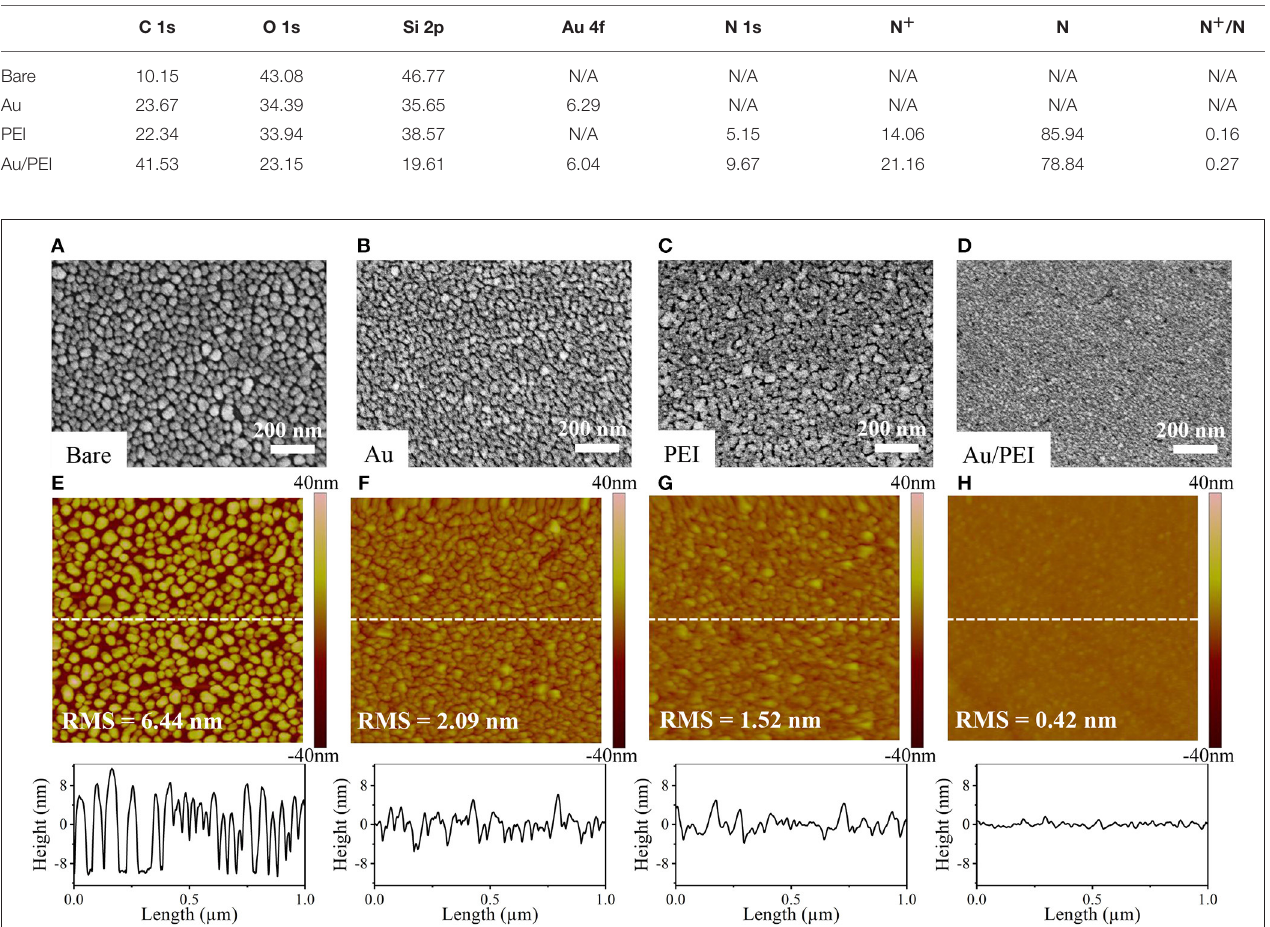
TABLE 1 | Atomic concentration (%) of different samples determined by XPS analysis.